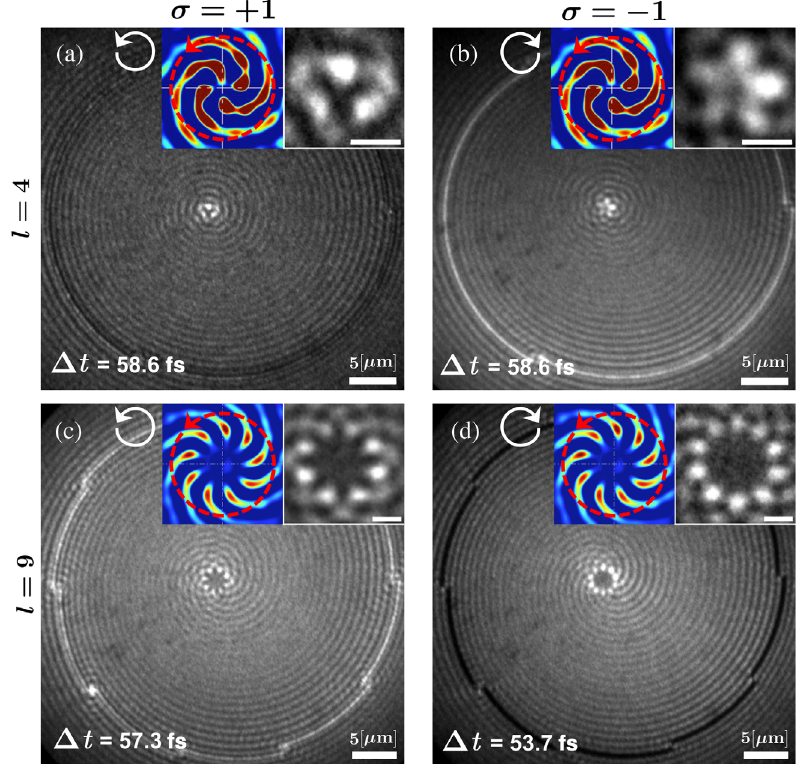
FIG. 3. Experimental raw data of spin orbit mixing of light with plasmonic vortices. The color insets are the FDTD-calculated out-of- plane field components of the interacting plasmonic vortex l ¼ 4 (a,b) and l ¼ 9 (c,d) for reference. The red dashed arrows represent the counter-clockwise (positive) rotation of the plasmonic vortex. The white circular arrows indicate the handedness of the polarization of the 3D light pulse: σ ¼ þ 1 (a,c) and σ ¼ − 1 (b,d). The grayscale insets are zoom-ins of the center, and they show excited electron distributions having multilobes of azimuthal order 3 (a), 5 (b), 8 (c), and 10 (d). All of them indicate patterns related to l inset scale bar is 1 micron. All patterns revolve as a function of the light-plasmon delay time Δ t around the center of the vortex in a counter-clockwise direction (see full movies in the SM